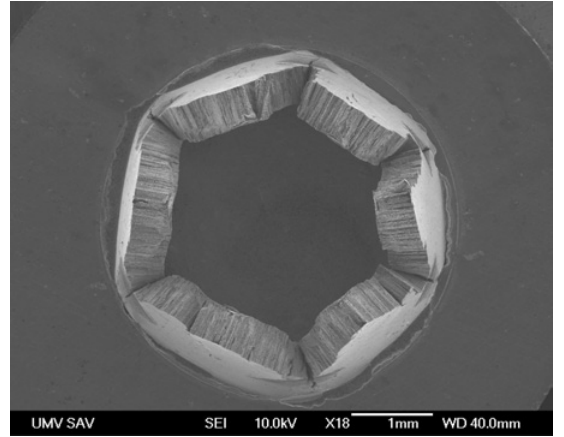
Figure 10. Shape of the fracture after SP test.